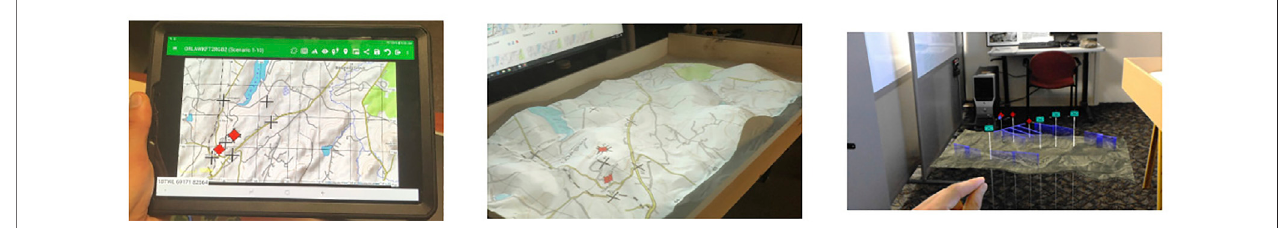
FIGURE 4 | Technologies from User ’ s